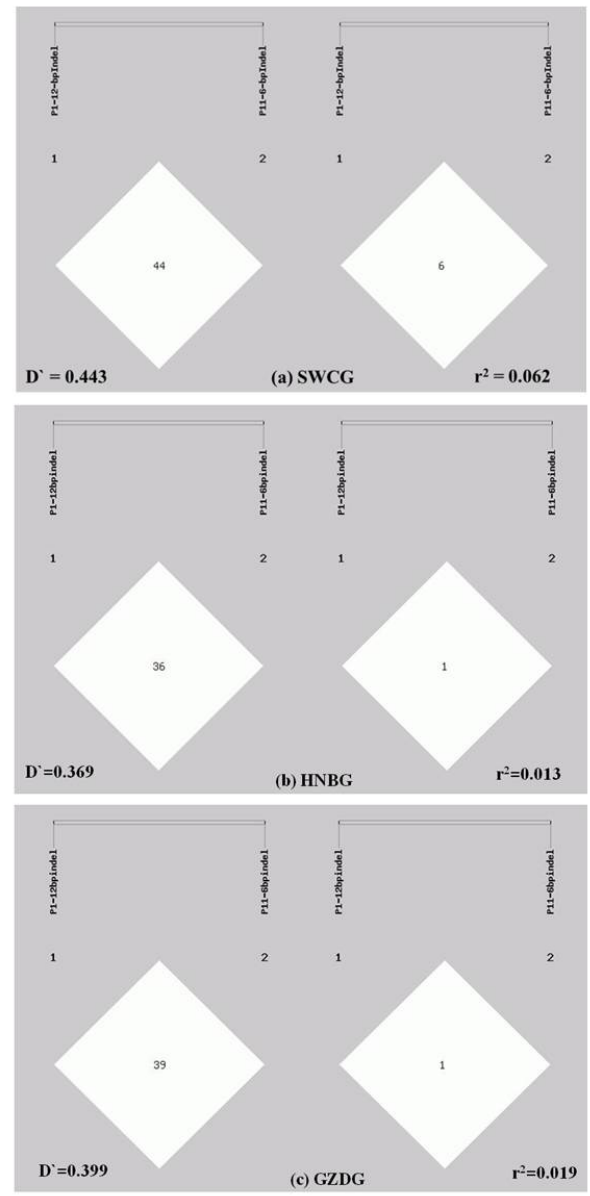
Figure 2. Linkage disequilibrium analyses of the P1-12-bp indel and P11-6-bp indel. (a) analysis result in SWCG ( D (cid:48) = 0 . 443; r 2 = 0 . 062); (b) analysis result in HNBG ( D (cid:48) = 0 . 369; r 2 = 0 . 013); (c) analysis result in GZDG ( D (cid:48) = 0 . 399; r 2 = 0 .